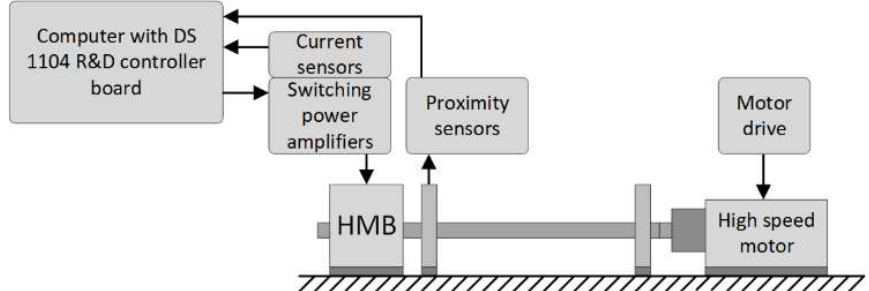
Figure 6. A test bench for the HMB.